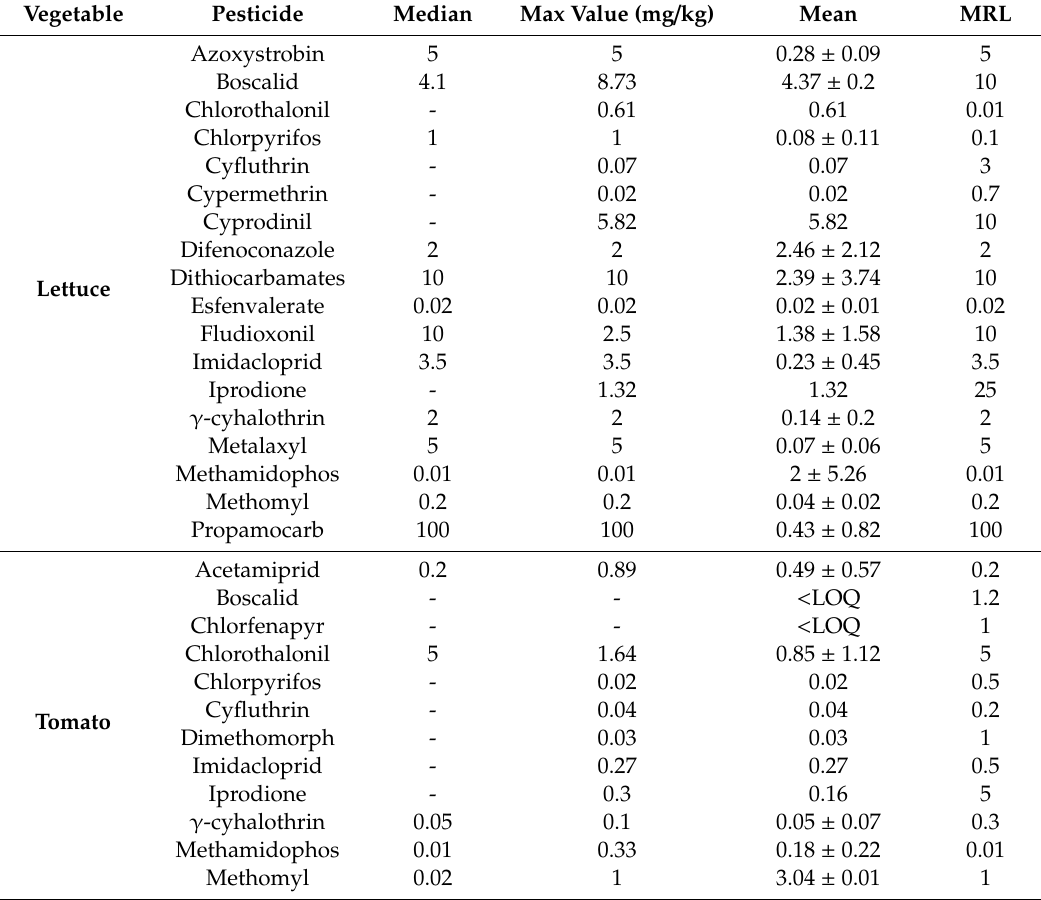
Table 2. Pesticides detections in tomatoes ( n = 23) and lettuces ( n = 57). Vegetable